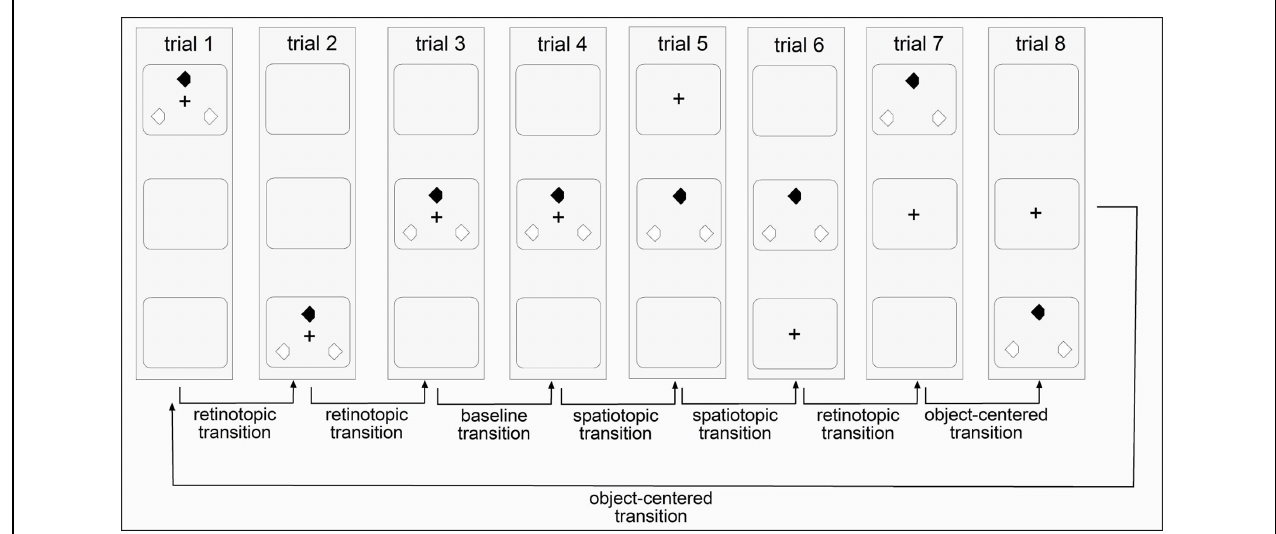
FIGURE 2 | Illustration of the four reference frame conditions in invariant sequences of Experiment 1 (vertical presentations). Each trial is marked by an upright standing rectangle and the three squares inside the rectangle mark the three potential display regions for the fixation cross and the search items to